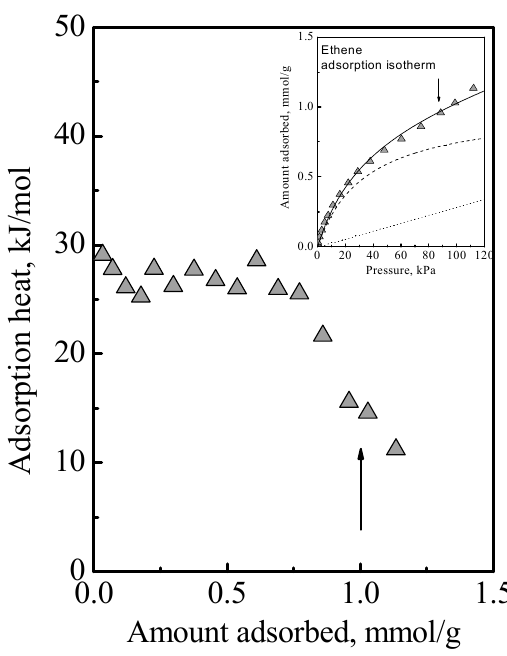
Figure 3. Heat of adsorption as a function of surface concentration of ethene on SAPO-34 zeolite at 25 °C. The inset shows the corresponding isotherm and the best fit curve and its components of Langmuir and Henry isotherms. The arrows indicate the acid site density, which is 1 mmol/g.